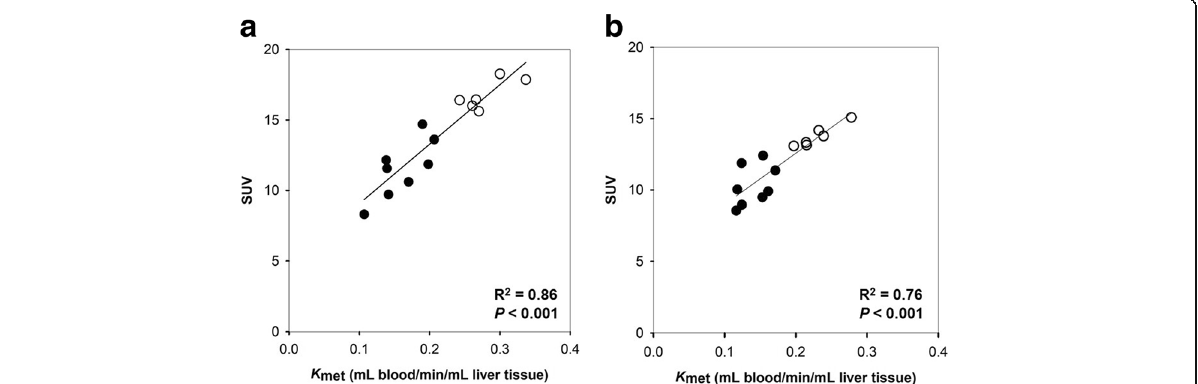
Fig. 2 Correlations between regional values of SUV and K met ( a ) and between whole-liver values of SUV and K met ( b ) for 18 F-FDGal PET/CT in patients with cirrhosis (black circle) and healthy subjects (white circle). Results from reconstruction algorithm with resolution modelling and a 168 matrix are shown with fitted linear regression